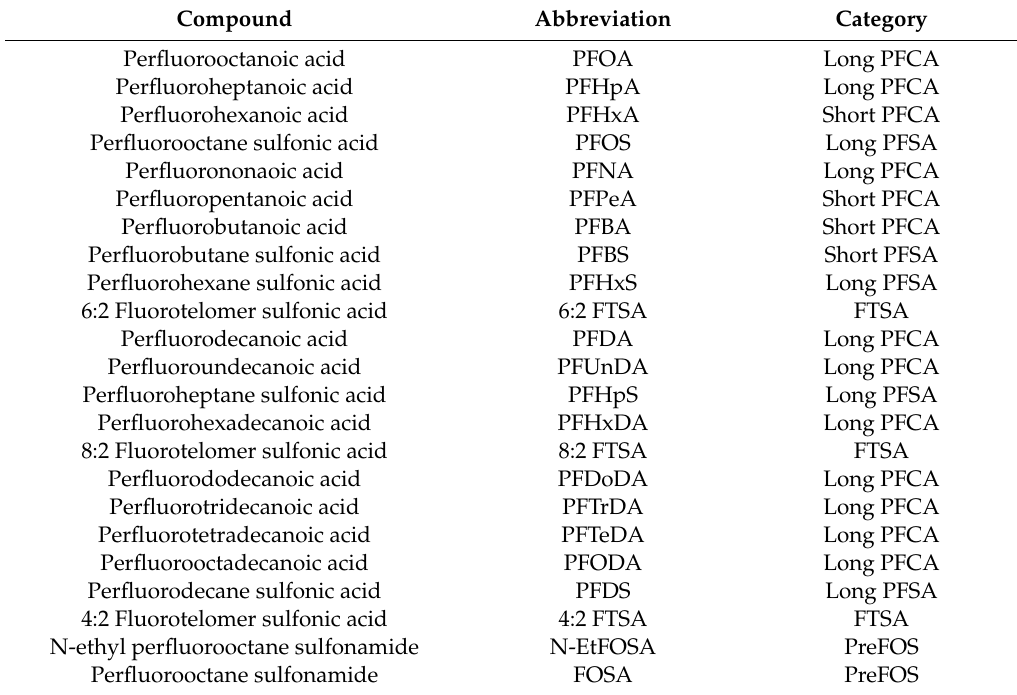
Table 1. Sudied compounds, their abbreviations and